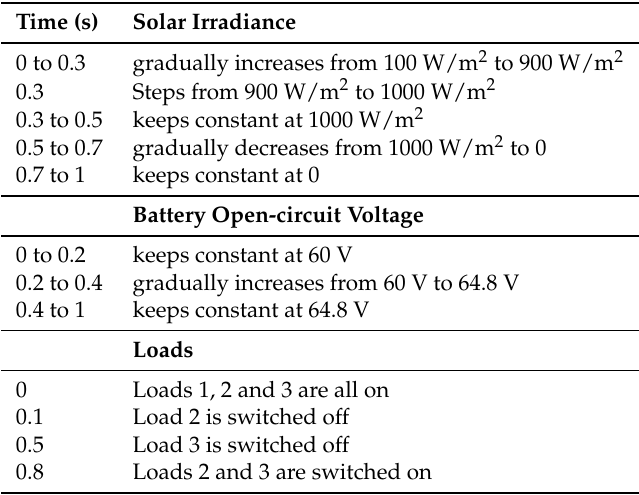
Table 7. Operation events scheduled in the